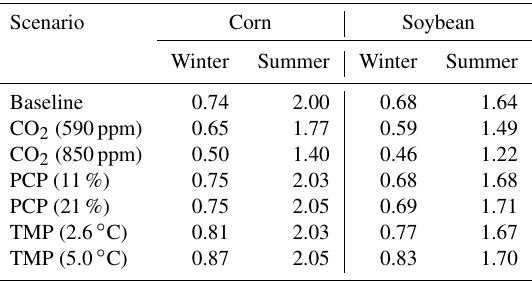
Table A3. Seasonal evapotranspiration (ET, mmha − 1 10 2 ) under climate sensitivity scenarios (CO 2 : carbon dioxide concentration; PCP: precipitation; and TMP: